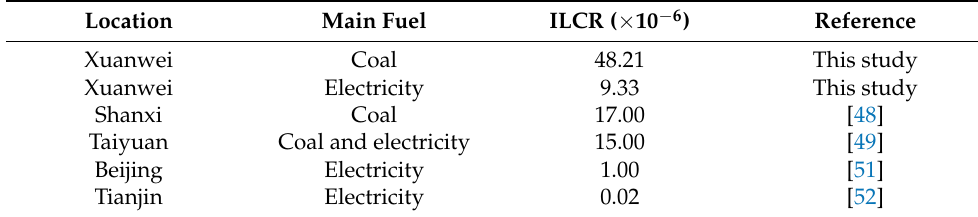
Table 5. Estimated incremental lifetime cancer risk (ILCR) in different